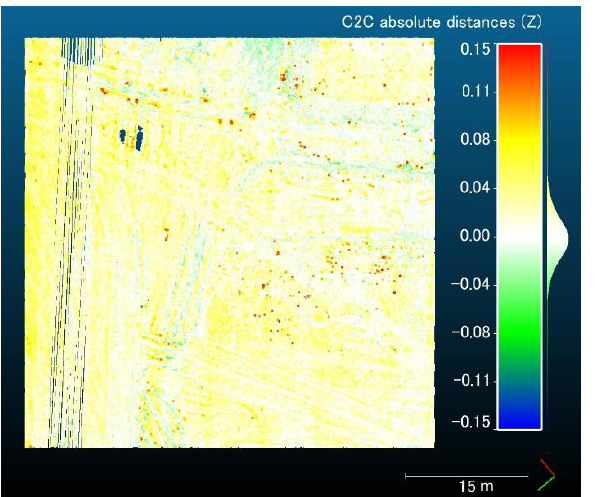
Figure 6. Verification area (Left: SfM/MVS, Right: Tint map)